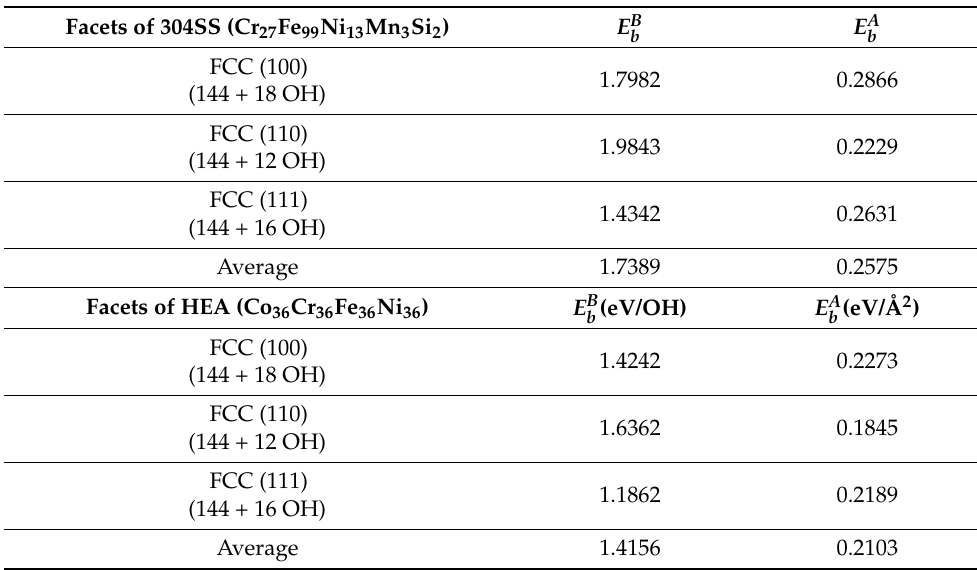
Table 6. Average bond energy per bond ( E B (110), and (111) of FCC structure for 304SS and CoCrFeNi